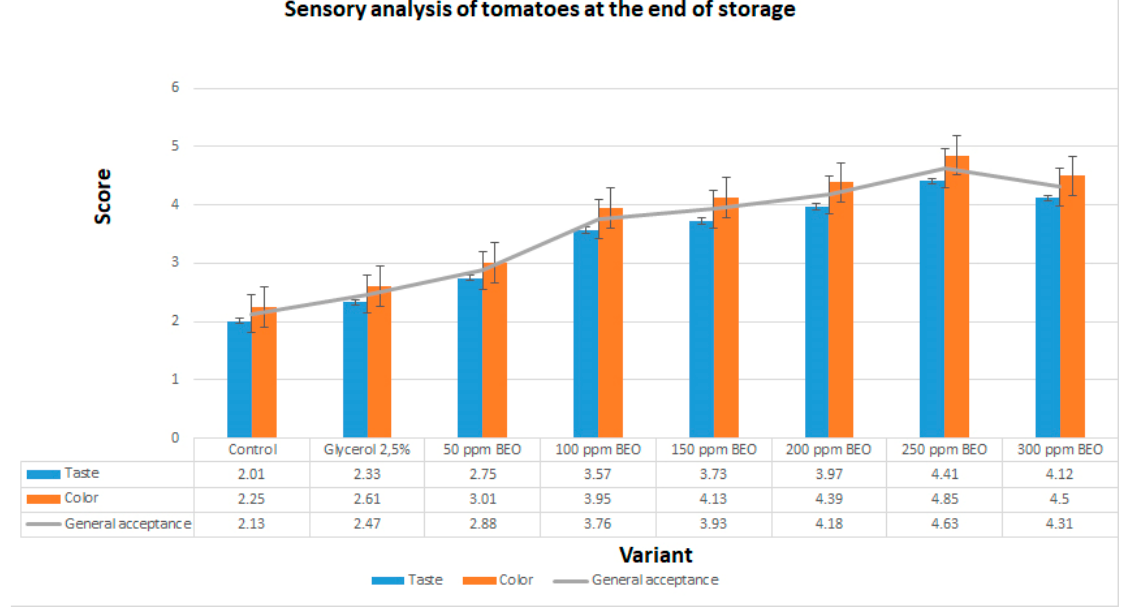
Figure 13. Sensory analysis of the tomato at the end of